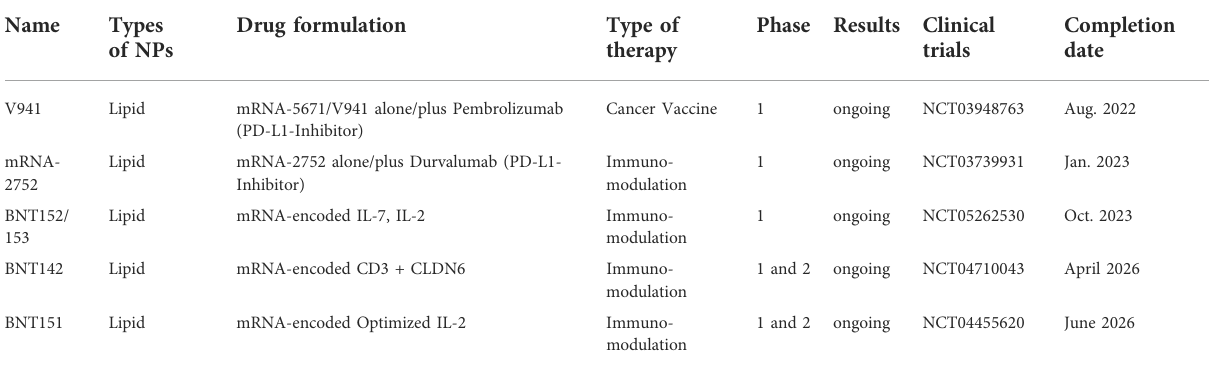
TABLE 2 | Clinical trials of NP-based